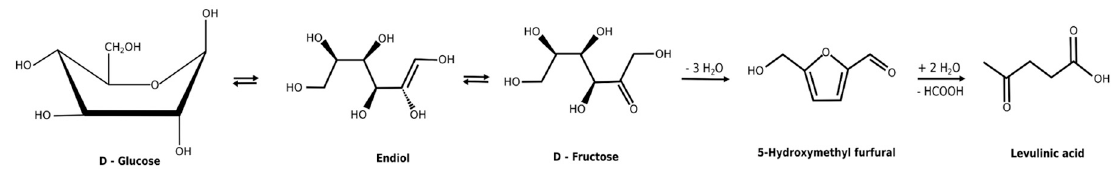
Figure 1. Synthesis of LA starting from D ‐ glucose.